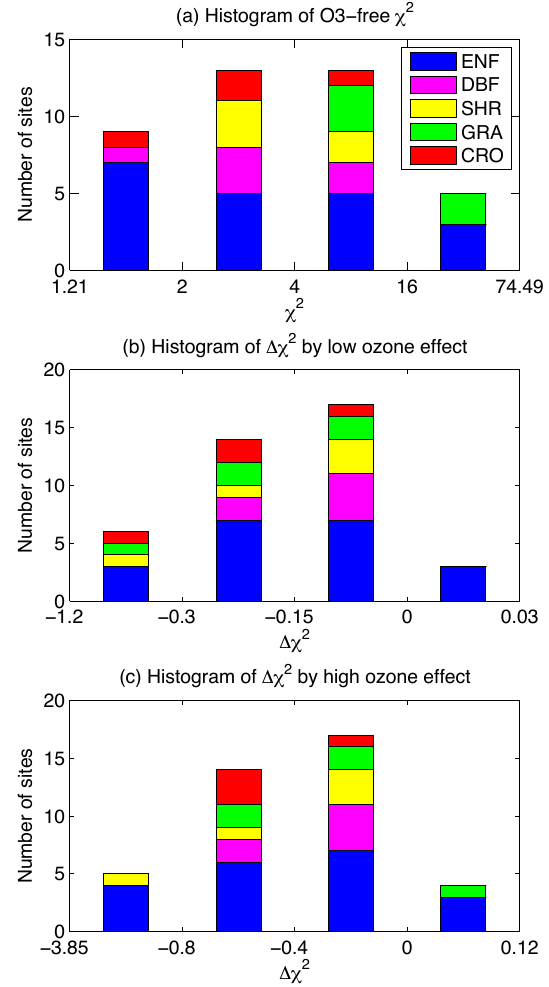
Figure 2. Histogram of (a) χ 2 for O 3 -free GPP and changes in χ 2 Fig. 2. Histogram of (a) χ 2 for O -free GPP and changes in χ 2 after the inclusion of O 1033 3 after the inclusion of O 3 damage impact with (b) low and (c) high damage impact with (b) low and (c) high O sensitivity. Each bar represents the number 1034 O 3 sensitivity. Each bar represents the number of sites where the 3 of sites where the χ 2 or Δχ 2 of simulations fall between the specific thresholds as defined 1035 χ 2 or 1χ 2 of simulations fall between the specific thresholds as defined by the x axis intervals. The minimum and maximum of χ 2 by the x-axis intervals. The minimum and maximum of χ 2 or Δχ 2 are indicated as the two 1036 or 1χ 2 are indicated as the two ends of x axis in the plots. The ends of x-axis in the plots. The land cover definitions are: ENF, Evergreen Needleleaf 1037 land cover definitions are as follows: ENF, Evergreen Needleleaf Forest; DBF, Deciduous Broadleaf Forest; SHR, Shrubland; GRA, Grasslands; CRO, 1038 Forest; DBF, Deciduous Broadleaf Forest; SHR, Shrubland; GRA, Croplands. Results for each site are detailed in Fig. S6. 1039 Grasslands; CRO, Croplands. Results for each site are detailed in Fig. S6 in the